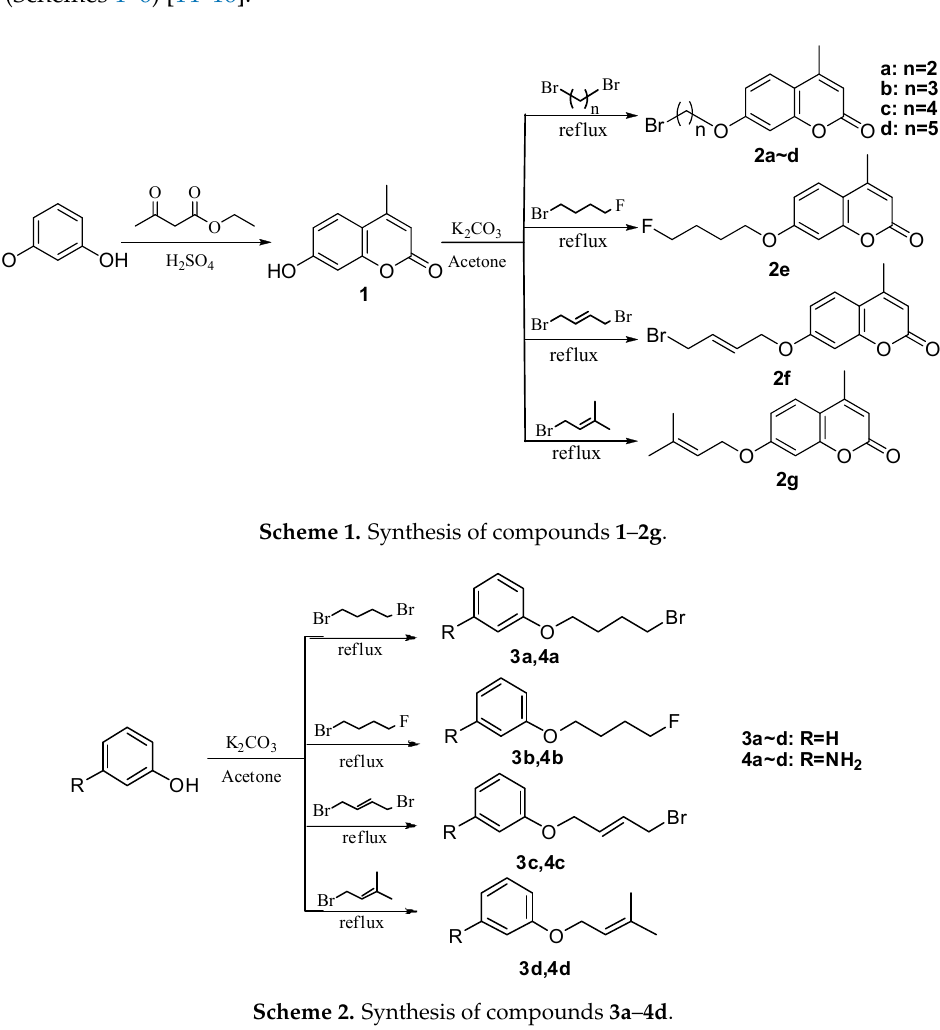
Scheme 2. Synthesis of compounds 3a – 4d .